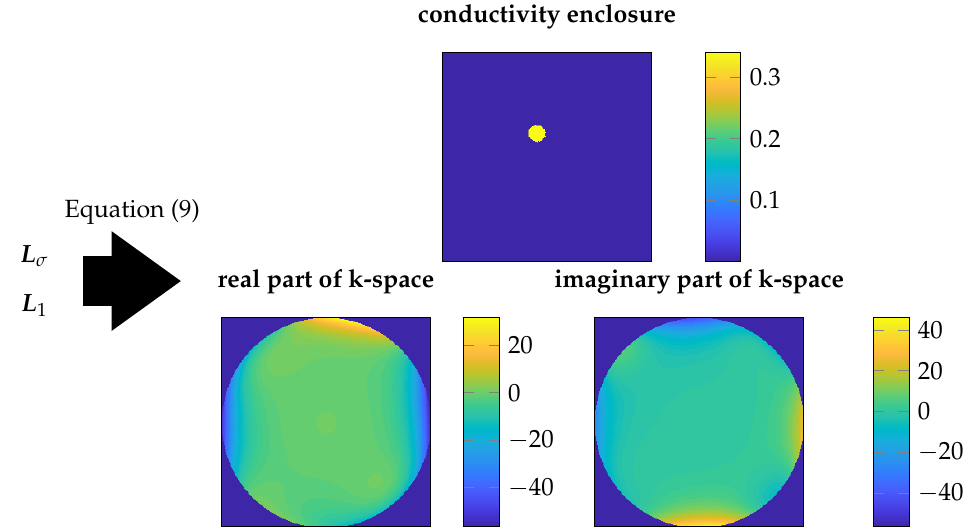
Figure 3. Example of the k -space. At the top, the conductivity enclosure in our rectangular domain is given. In the bottom left part, the real part of the k-space is given, while the imaginary part is displayed on the right. The truncation radius is R 1 = 3.5. It is important to note that the size of the actual domain has no direct relation to the more abstract truncation radius, as the truncation radius is placed in the k-space.